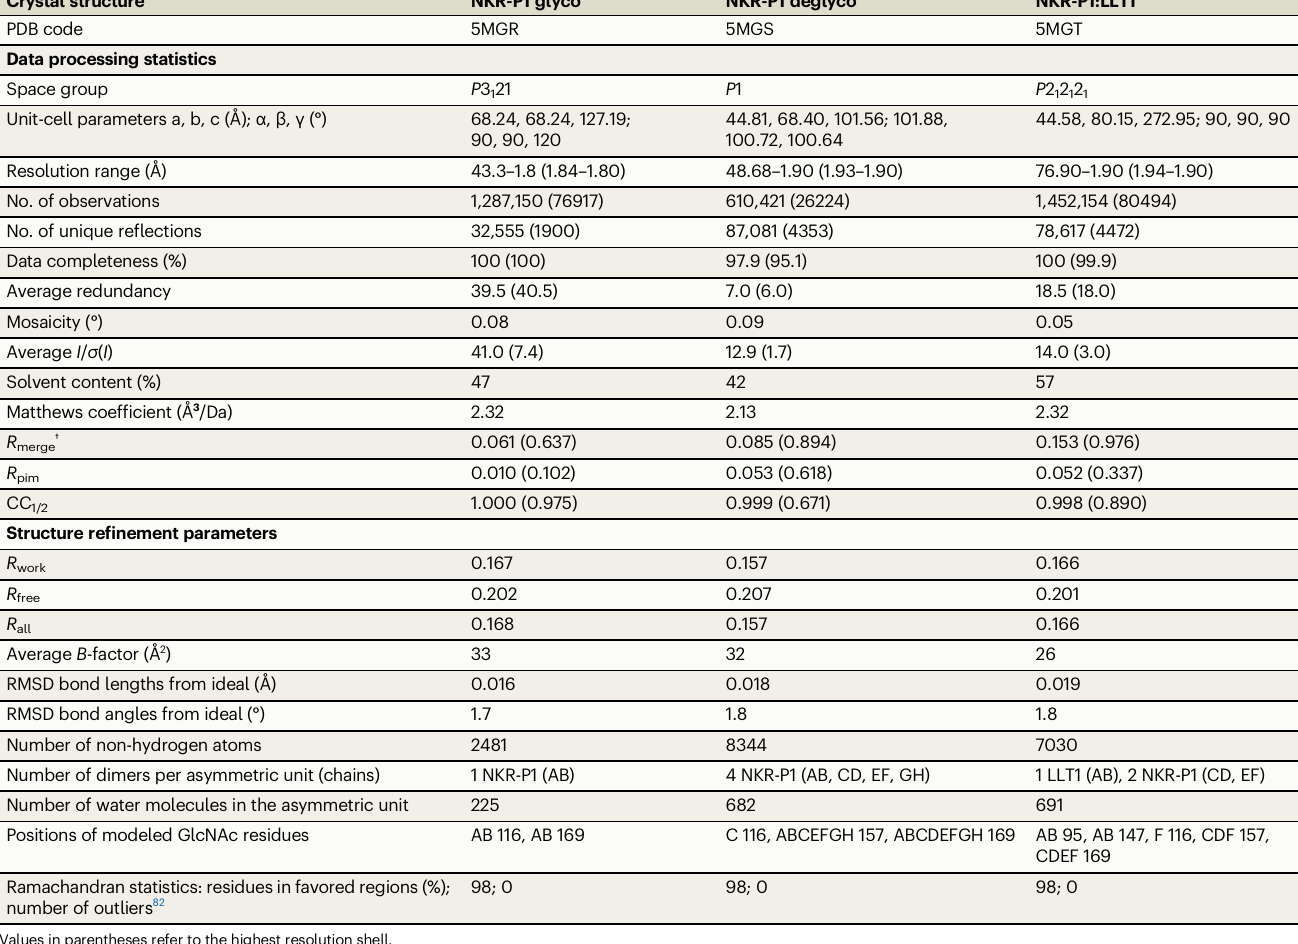
Table 1 | Data processing statistics and structure re fi nement parameters Crystal